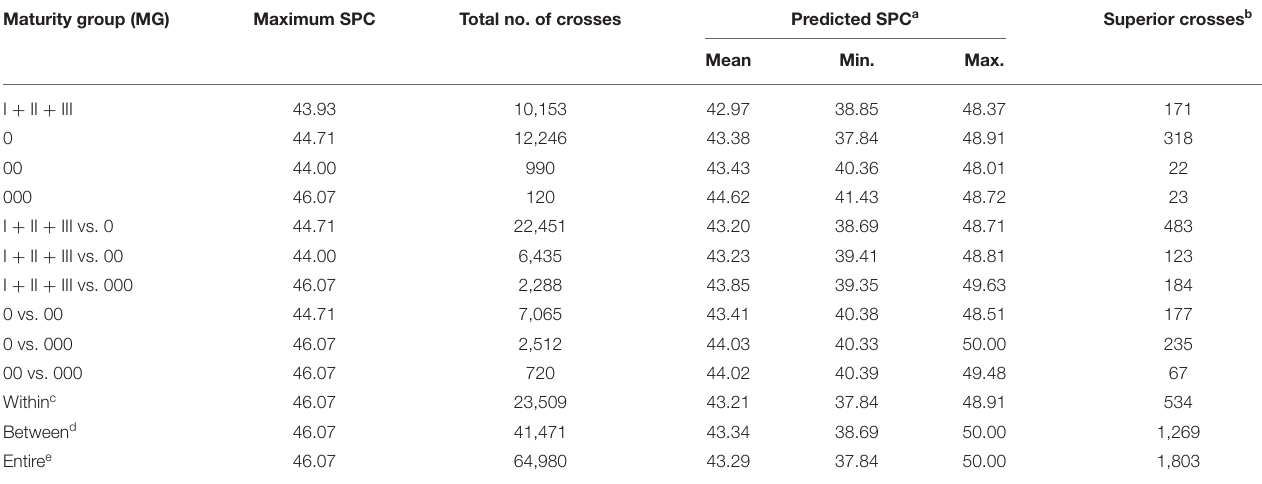
TABLE 4 | The predicted SPC of simple crosses within and between maturity groups. Maturity group (MG) Maximum SPC Total no. of crosses Predicted SPC a Superior crosses b Mean Min.